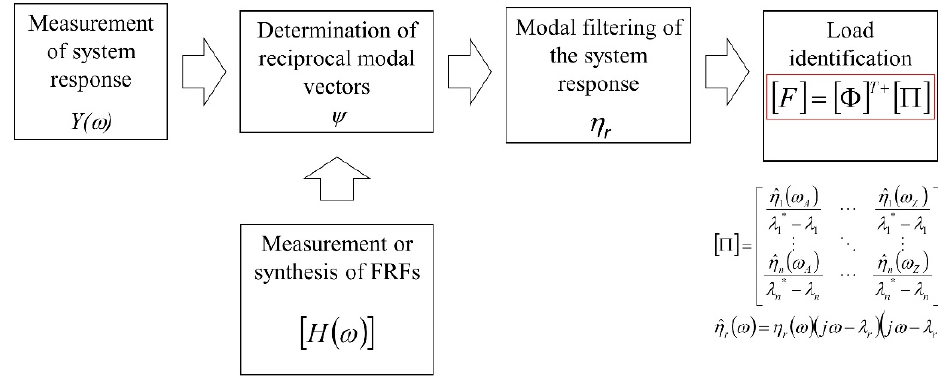
Figure 2. Block diagram of the modal filtration method.